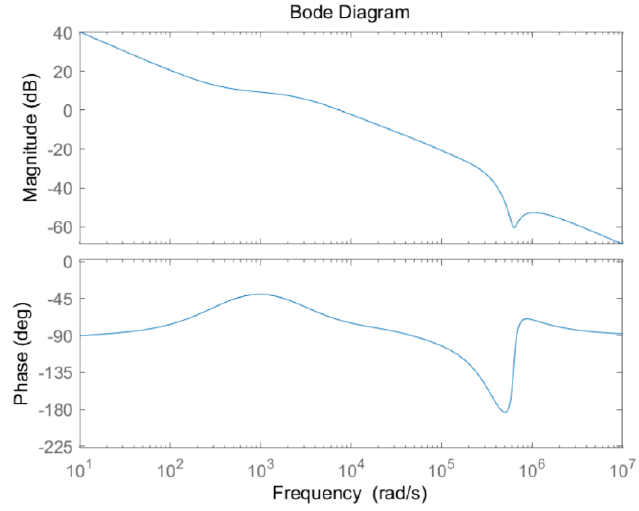
Figure 4. Bode diagram of the transfer function H ( s ).